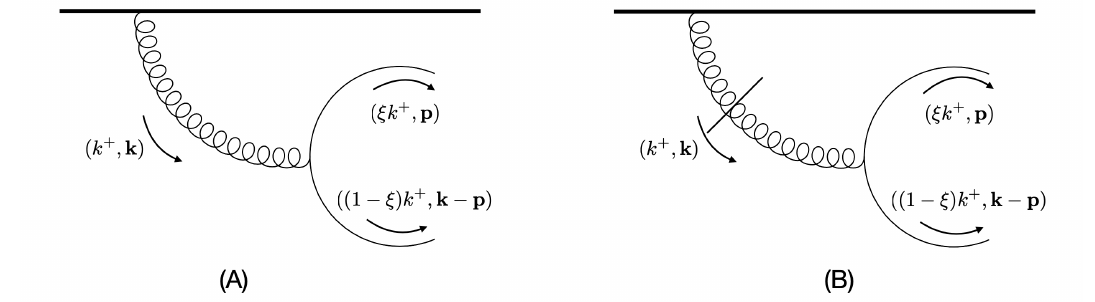
Figure 2 . Quark emission diagrams, where ξ is the defined as ξ ≡ p + /k + . The horizontal thick lines are valence charge current. Diagram (A) corresponds to the interaction H gqq (eq. (2.27)), and (B) to the instantaneous quark pair emission from the vertex H qq -inst (eq.